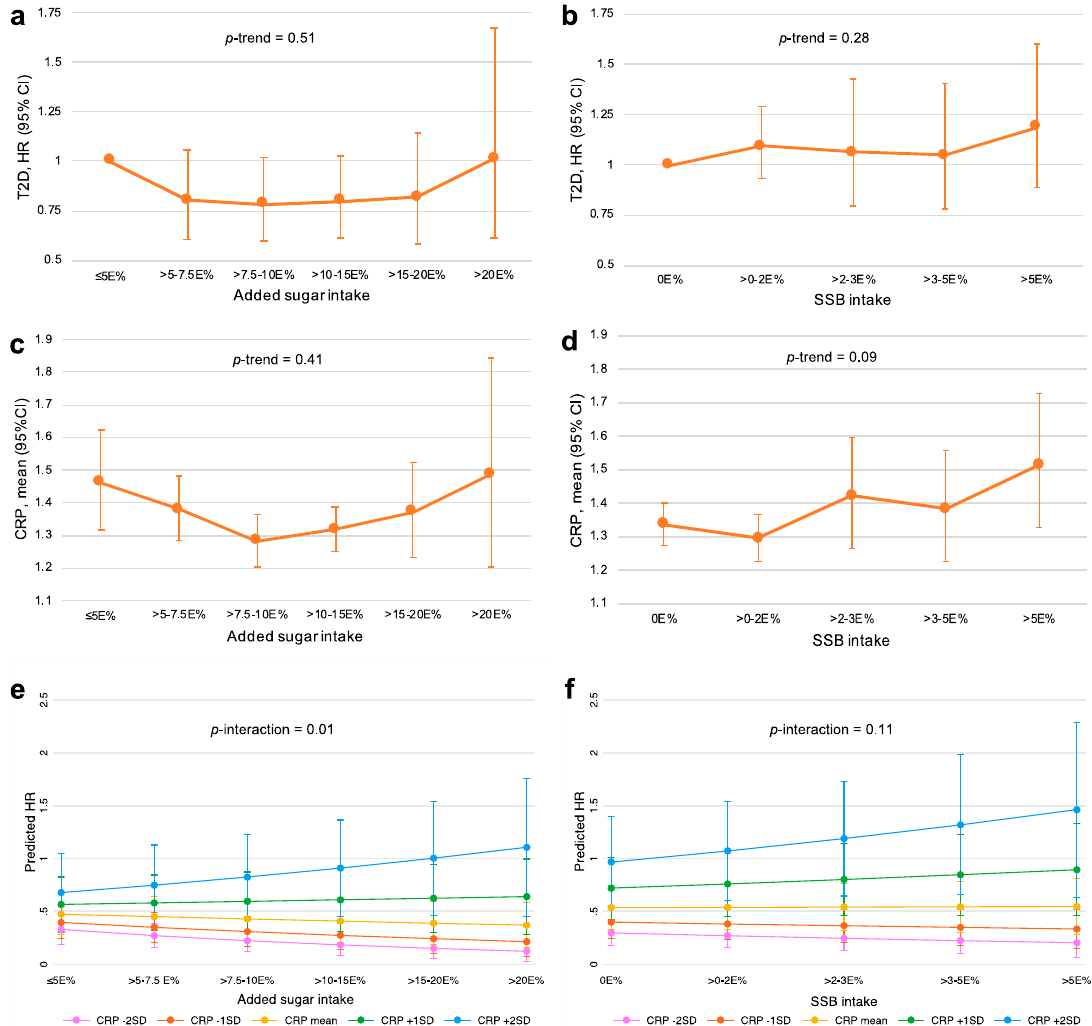
Figure 2. ( a ) Association between added sugar intake and T2D; ( b ) Association between SSB intake and T2D; ( c ) Association between added sugar intake and CRP; ( d ) Association between SSB intake and CRP; ( e ) Interaction between added sugar intake and CRP on T2D risk; ( f ) Interaction between SSB intake and CRP on T2D risk. Cox proportional hazards regressions and linear regressions were adjusted for age, sex, season, screening date, total energy intake, education, smoking, alcohol and LTPA. CRP was studied as log transformed and the predicted marginal means of CRP levels were exponentiated back for presentation. CRP, C-reactive protein; E%, percent of energy intake; HR, hazard ratio; LTPA, leisure time physical activity; SSB, sugar-sweetened beverage; T2D, type 2 diabetes.